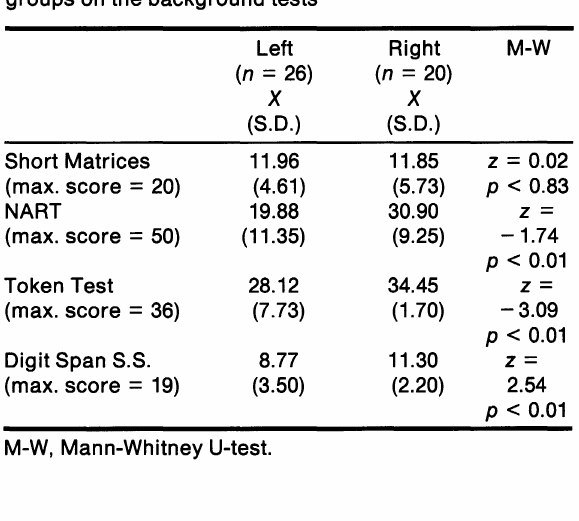
TABLE IV. Differences between the right and left lesion groups on the background tests